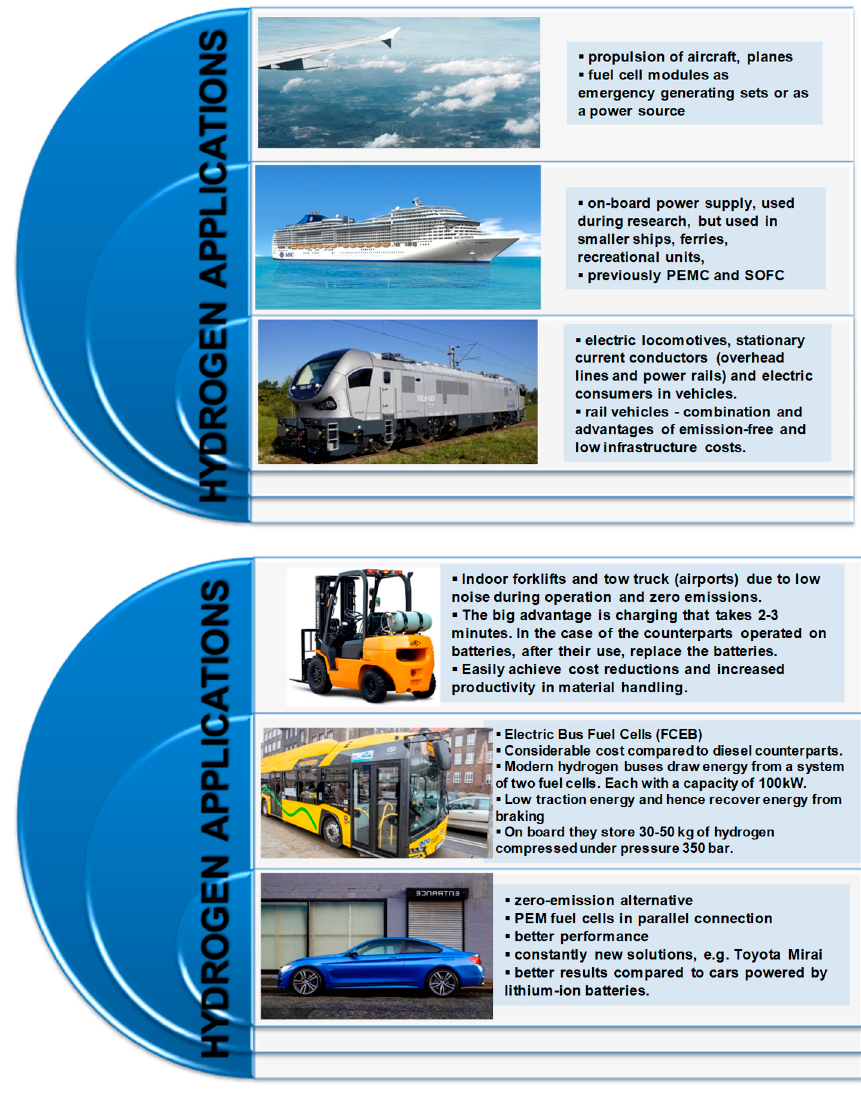
Figure 5. The use of hydrogen in various industries.